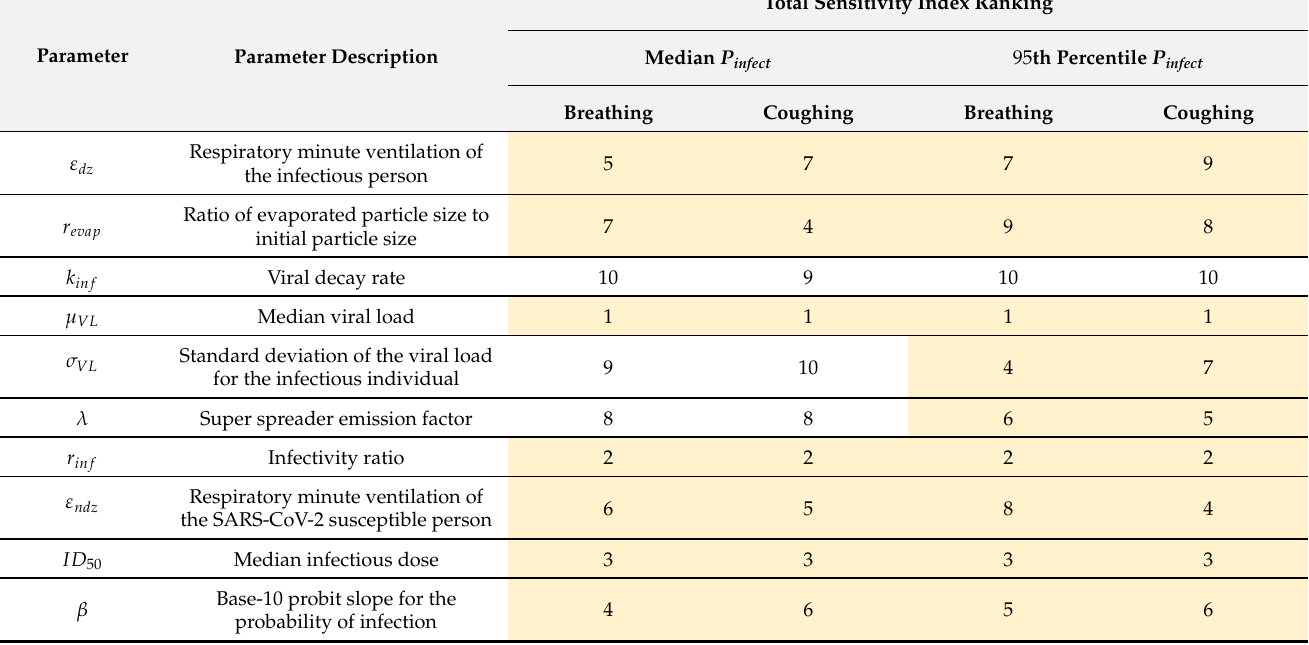
Table 3. Ranking of the total sensitivity indices for the median and 95th percentile P infect with breathing and coughing as the emission mechanisms. Yellow shaded cells indicate parameters that were determined to be statistically significant. Total Sensitivity Index Ranking Median P infect 95 th Percentile P infect